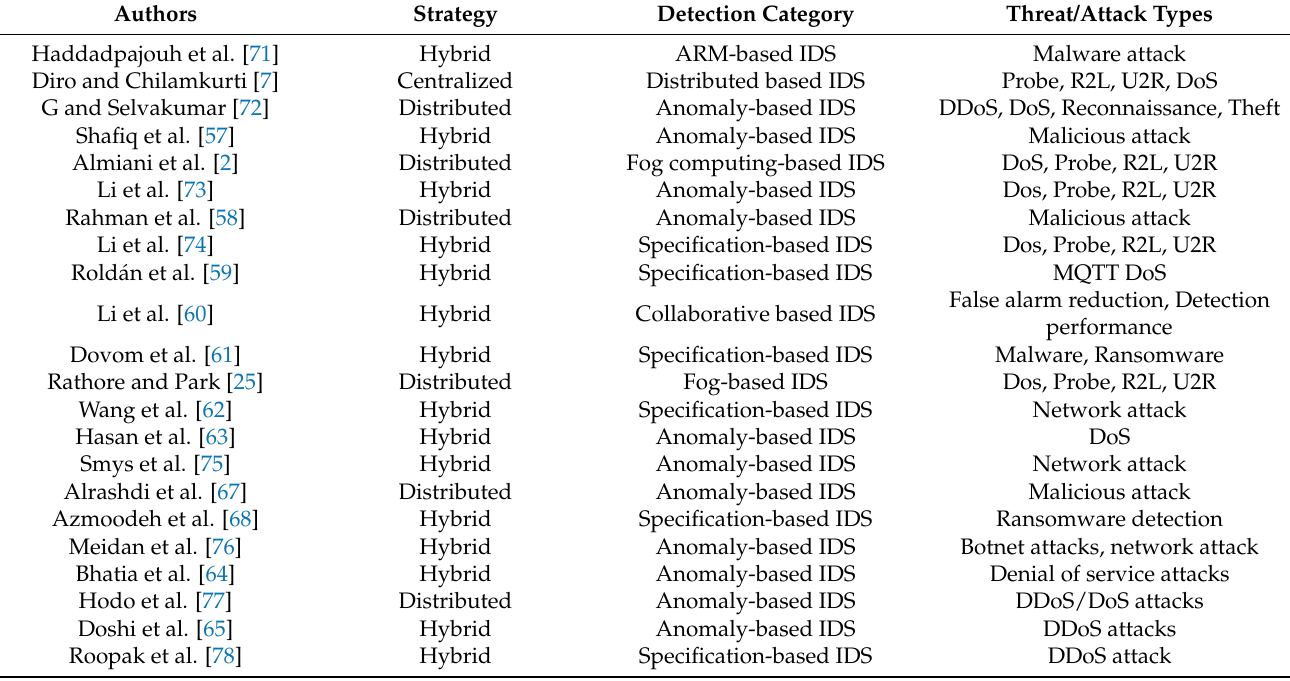
Table 7 summarizes the classification of the selected studies based on IDSs, strategies, detection categories, and types of detection/attack/threat in the IoT. According to the selected studies, most researchers used hybrid, centralized, and distributed strategies with ARM-based IDS, distribution-based IDS, anomaly-based IDS, fog computing-based IDS, and specification-based IDS as detection categories. The types of detection/attack/threat include malware attacks, denial-of-service (DoS), distributed denial-of-service (DDoS), mes- sage queuing telemetry transport DoS (MQTT DoS), botnet, network, ramping, blackhole, reconnaissance, sinkhole, wormhole attacks, and network traffic categorization. Table 7. Summary of studies classified based on IDSs and types of